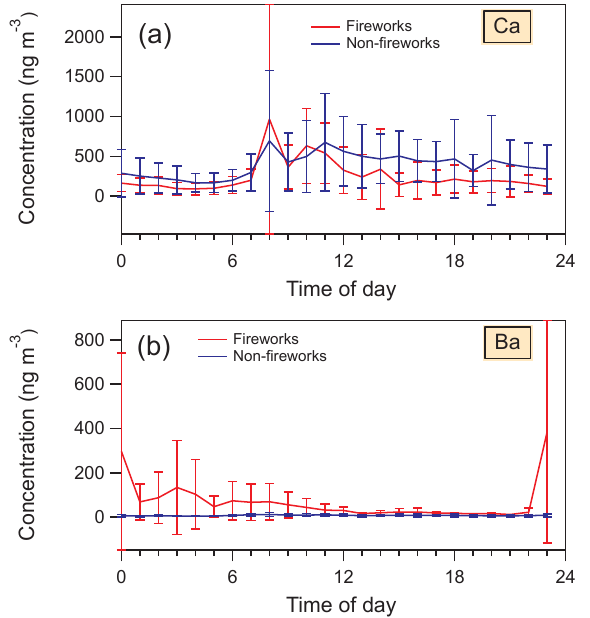
Figure 6. Mean diurnal variations of (a) Ca and (b) Ba, stratified for fireworks (red) and non-fireworks (blue) periods. Error bars denote ± 1 standard deviation of the averaging period. Diurnal variations for the other elements are shown in the Supplement (Fig. S4).